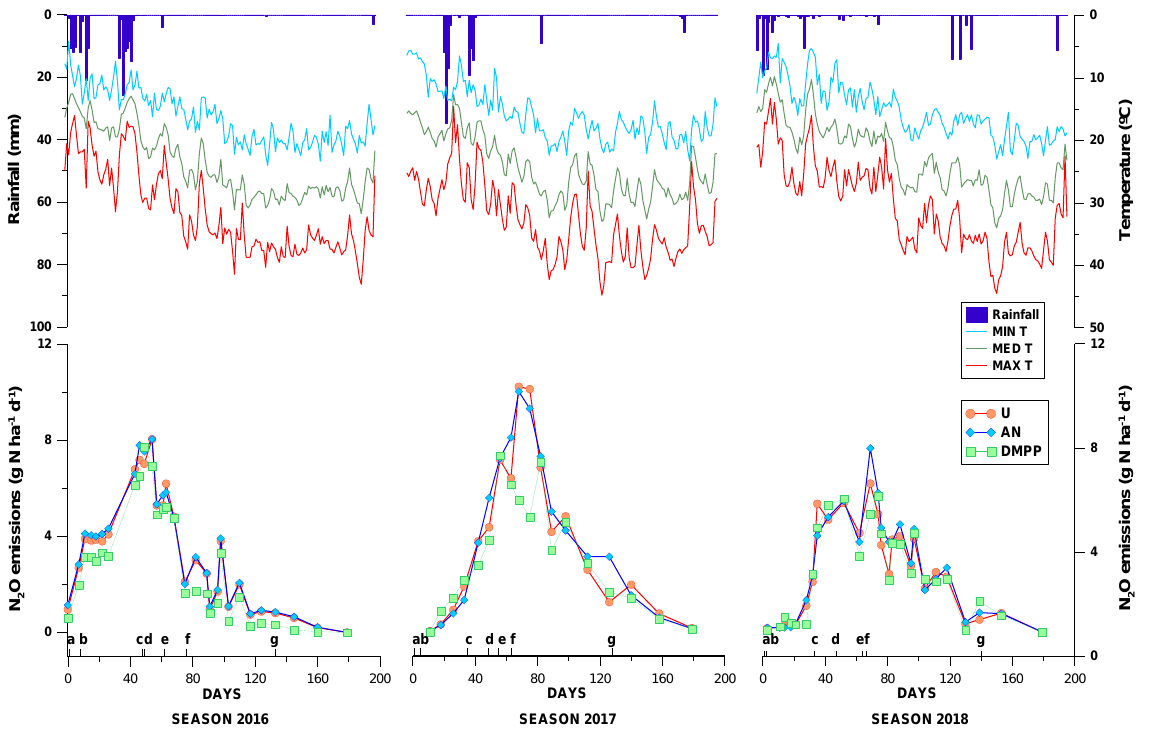
Figure 3. Daily emission of N 2 O according to the type of the used fertiliser. The different letters indicate: a = seeding; b = first fertilisation with DMPP; c = first fertilisation with U and AN; d = second fertilisation with DMPP; e = second fertilisation with U and AN; f = first irrigation; g = last irrigation.